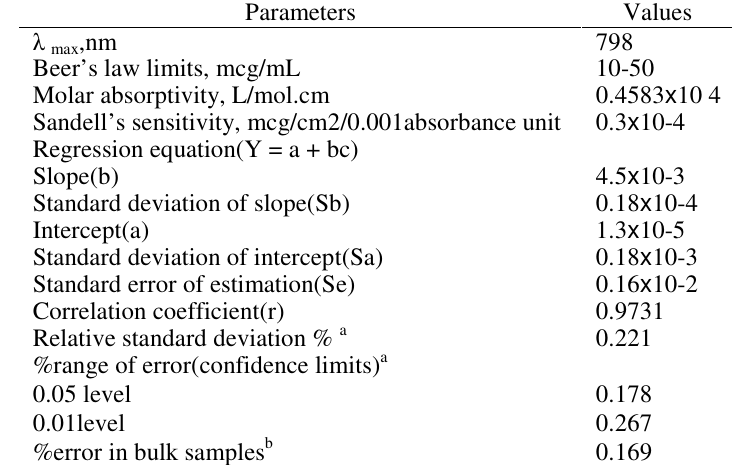
Table 2. Optical and regression characteristics, precision and accuracy of the proposed method for ceftibuten.